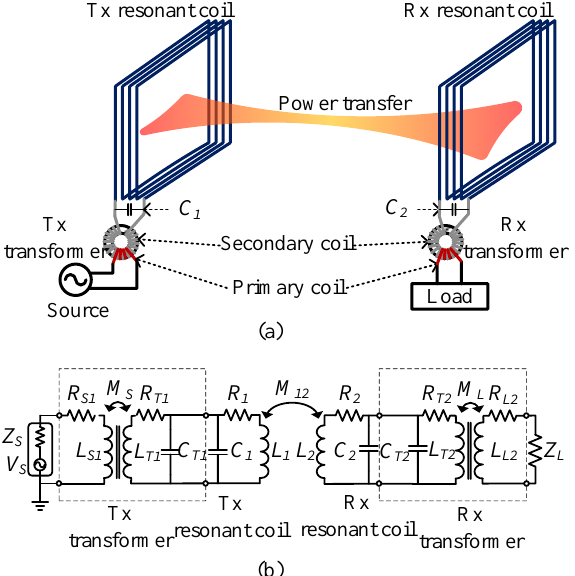
Figure 1. ( a ) Illustration of the proposed wireless power transfer (WPT) system and ( b ) its equivalent circuit.